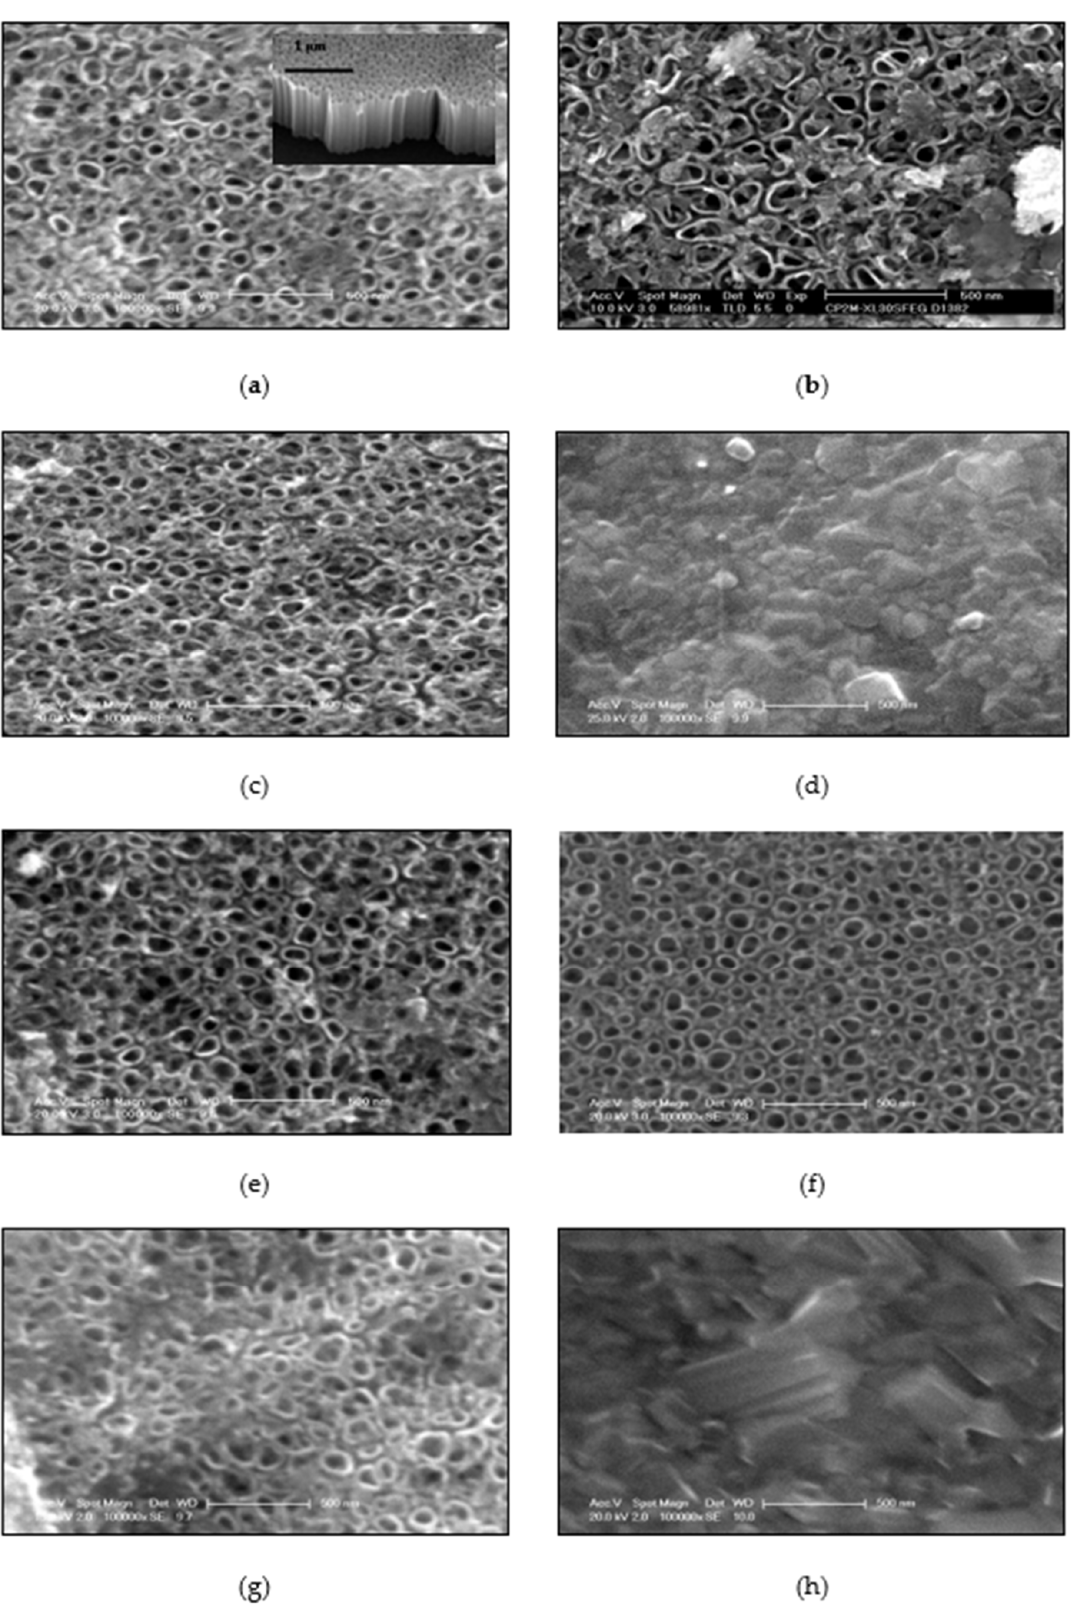
Figure 1. SEM images of TiO 2 nanotubes obtained from Ti deposed on Si: ( a ) before annealing; ( b ) at 450 °C; ( c ) at 650 °C; ( d ) at 900 °C; and from Ti foils: ( e ) before annealing; ( f ) at 450 °C; ( g ) at 650 °C; ( h ) at 900 °C.